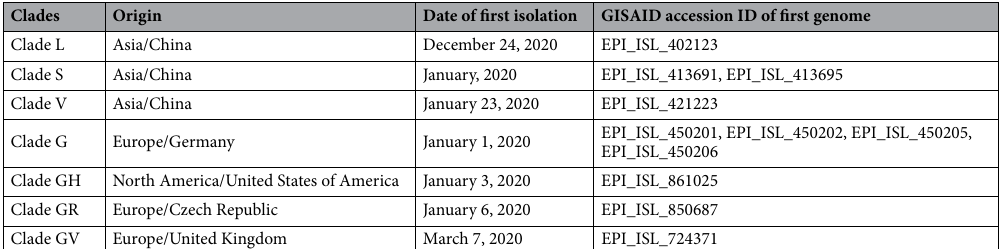
Table 3. The origins and the evolution time of SARS-CoV-2 clades.